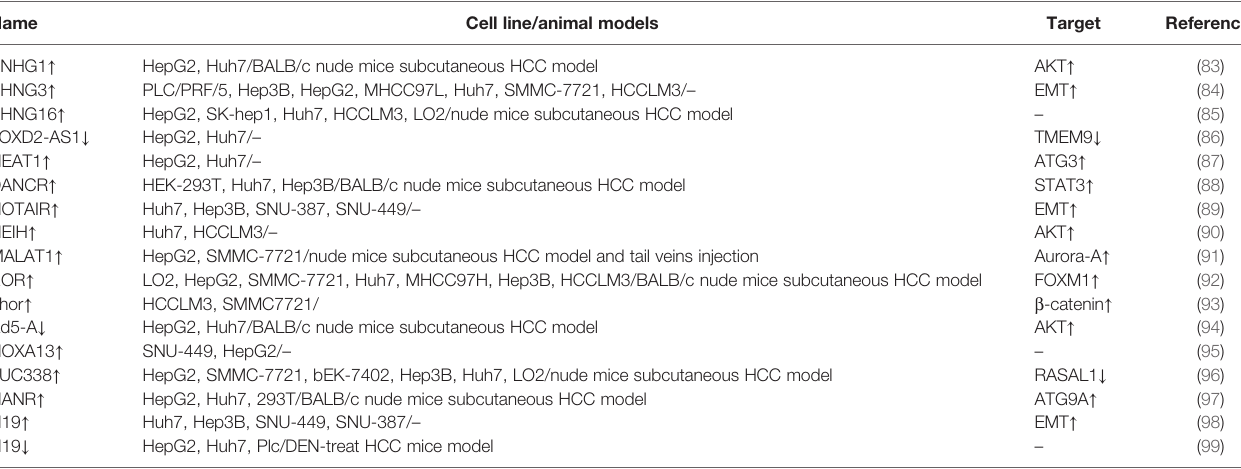
TABLE 2 | lncRNA and sorafenib resistance in HCC